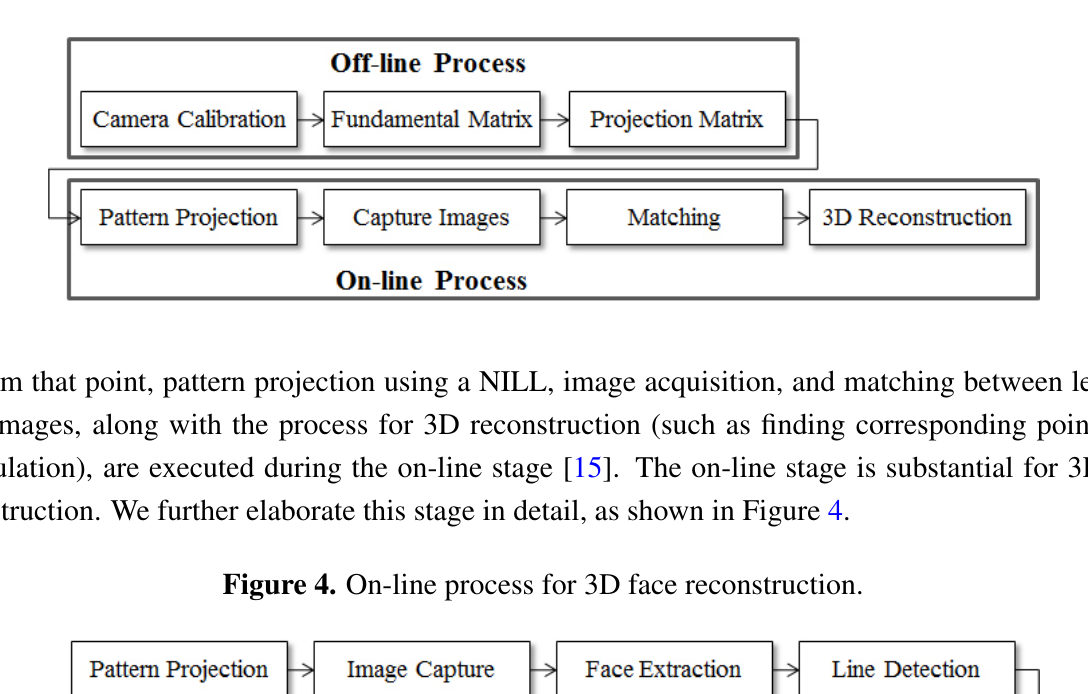
Figure 3. Full 3D face reconstruction process.